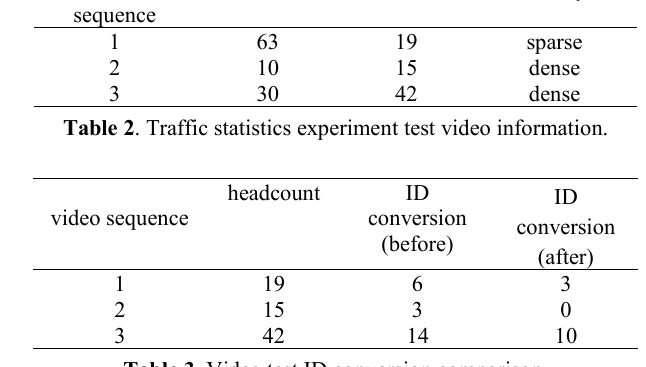
Table 3 . Video test ID conversion comparison.